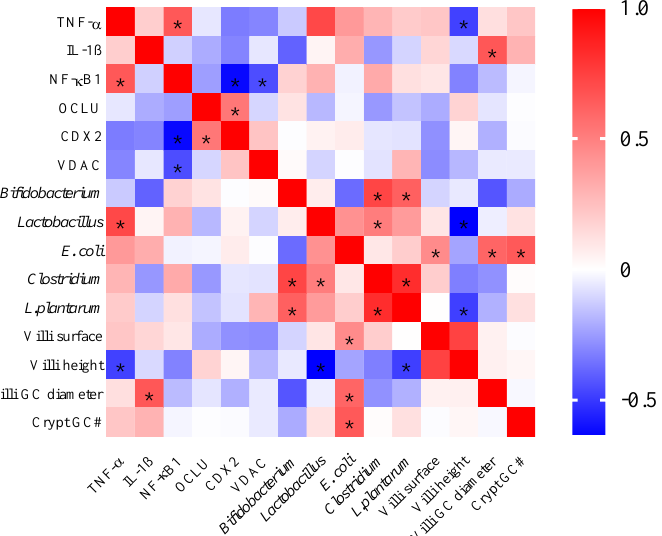
Figure 5. Correlation between intestinal biomarkers, bacterial population, and histological parame- ters. Colors from blue to red represented the p -value of the Spearman’s rank correlation coefficient. Blue: negative and red: positive correlation. * Significant correlation p < 0.05. TNF − α : tumor necrosis factor-alpha; NF − κ B: nuclear factor kappa beta; IL − 1 β : interleukin 1 beta; MUC2: mucin 2; OCLN: occludin; CDX2: caudal-related homeobox transcriptional factor 2; VDAC: voltage-dependent anion channel. GC: goblet cells; #: number.